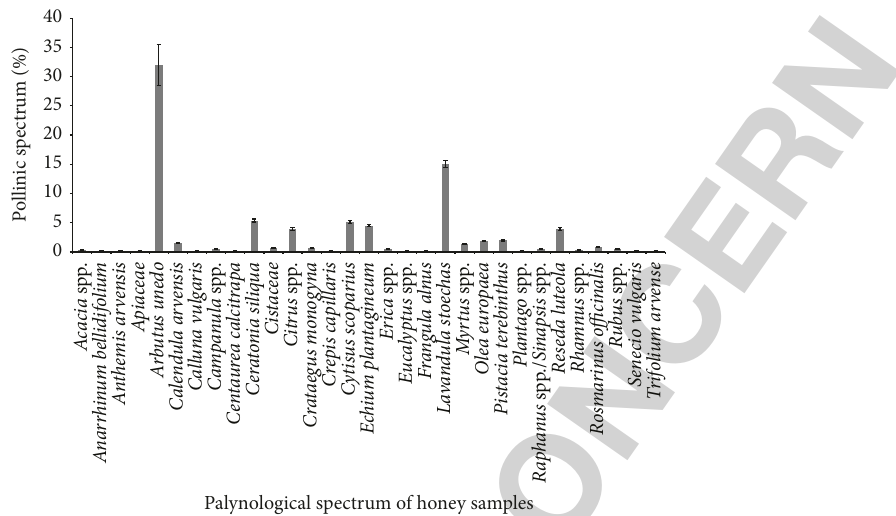
Figure 1: Palynological spectrum of strawberry tree ( Arbutus unedo ) honey samples.